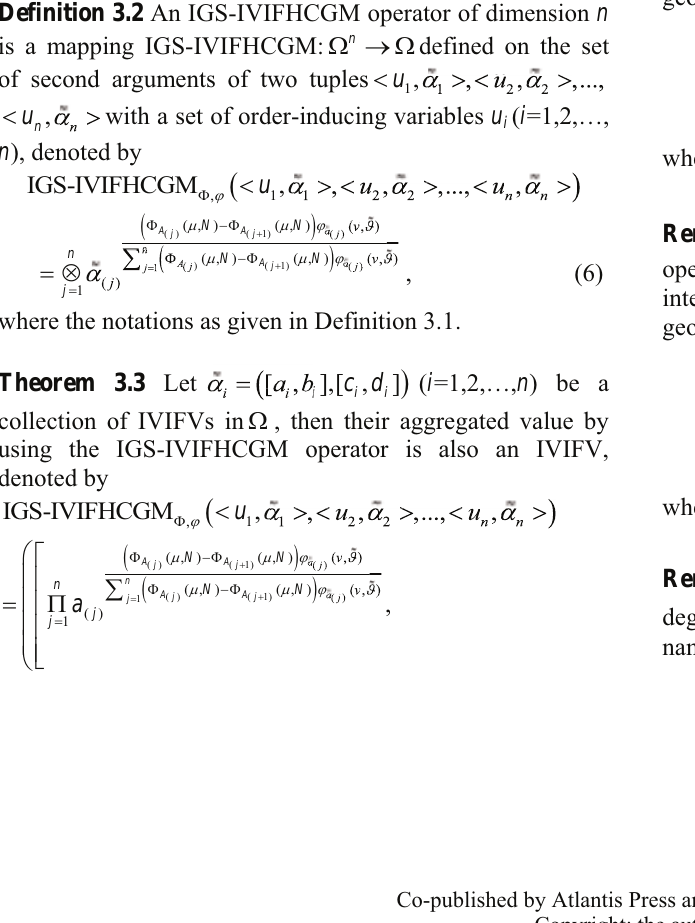
IVIFHCGM operator reduces to be the induced (cid:36)(cid:87)(cid:68)(cid:81)(cid:68)(cid:86)(cid:86)(cid:82)(cid:89)(cid:182)(cid:86) interval-valued intuitionistic fuzzy hybrid weighted geometric mean (I-IVIFHWGM) operator